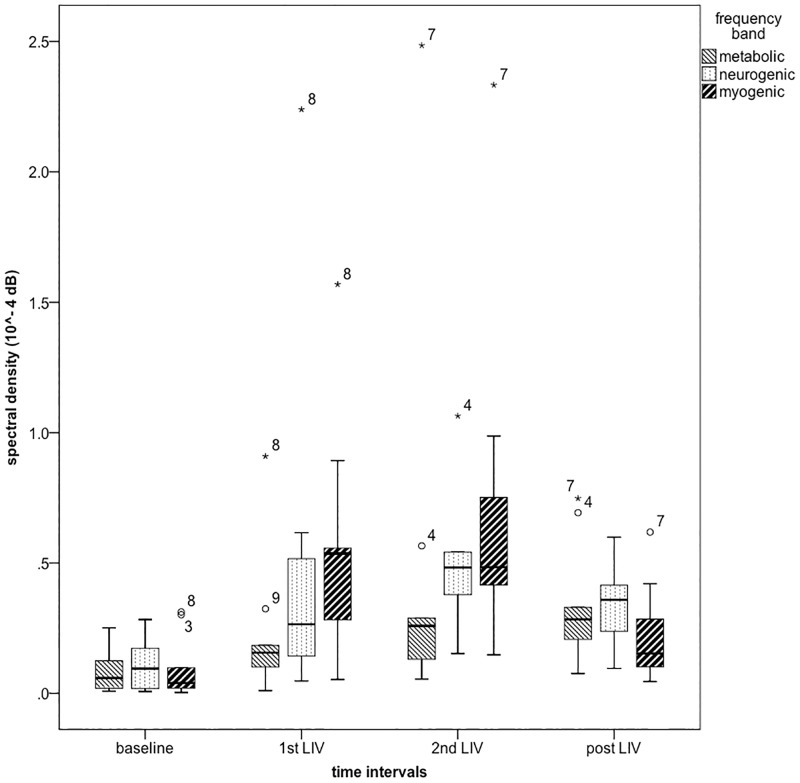
Boxplots of spectral densities at foot (n = 9).Outliers (beyond 1.5 interquartile range) are marked with subject ID.